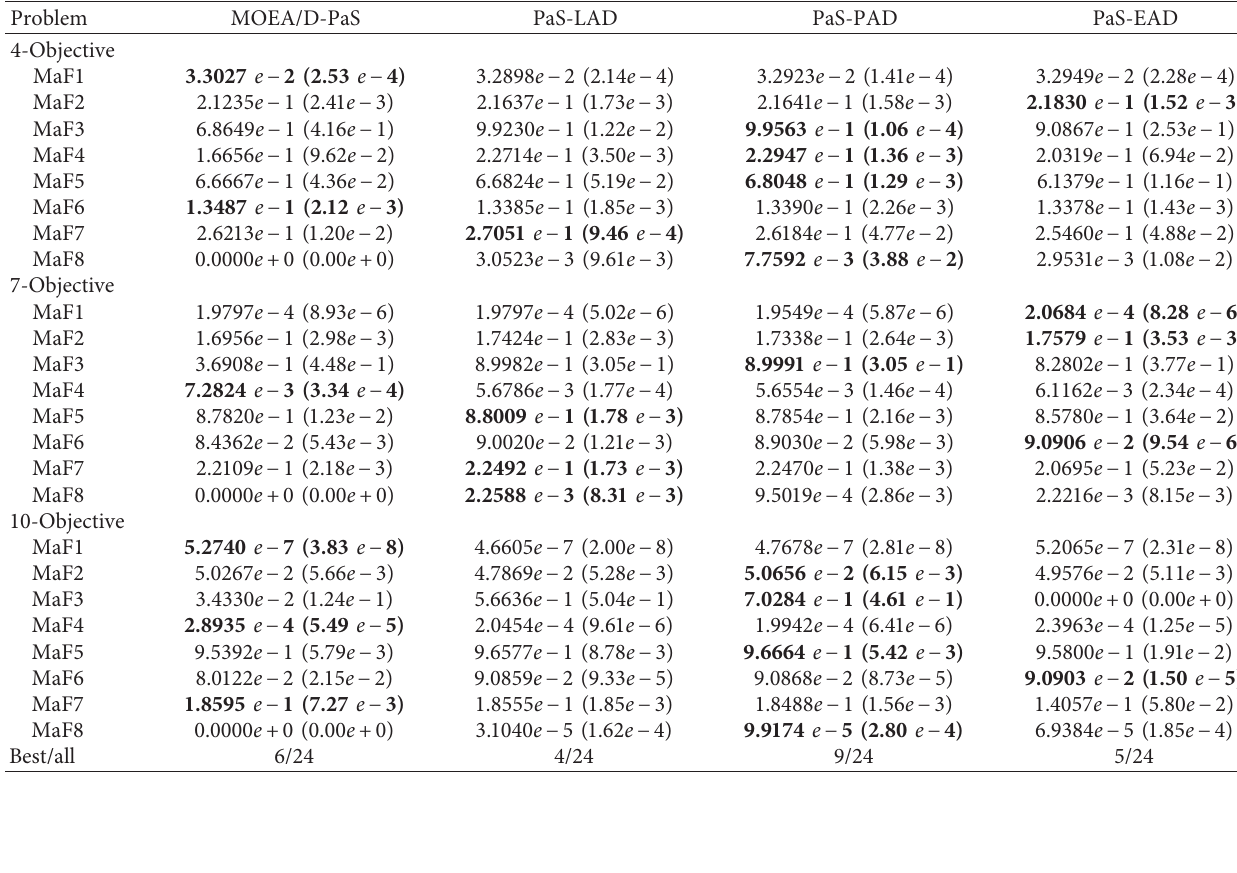
Table 5: HV metric (mean/std) comparison results on